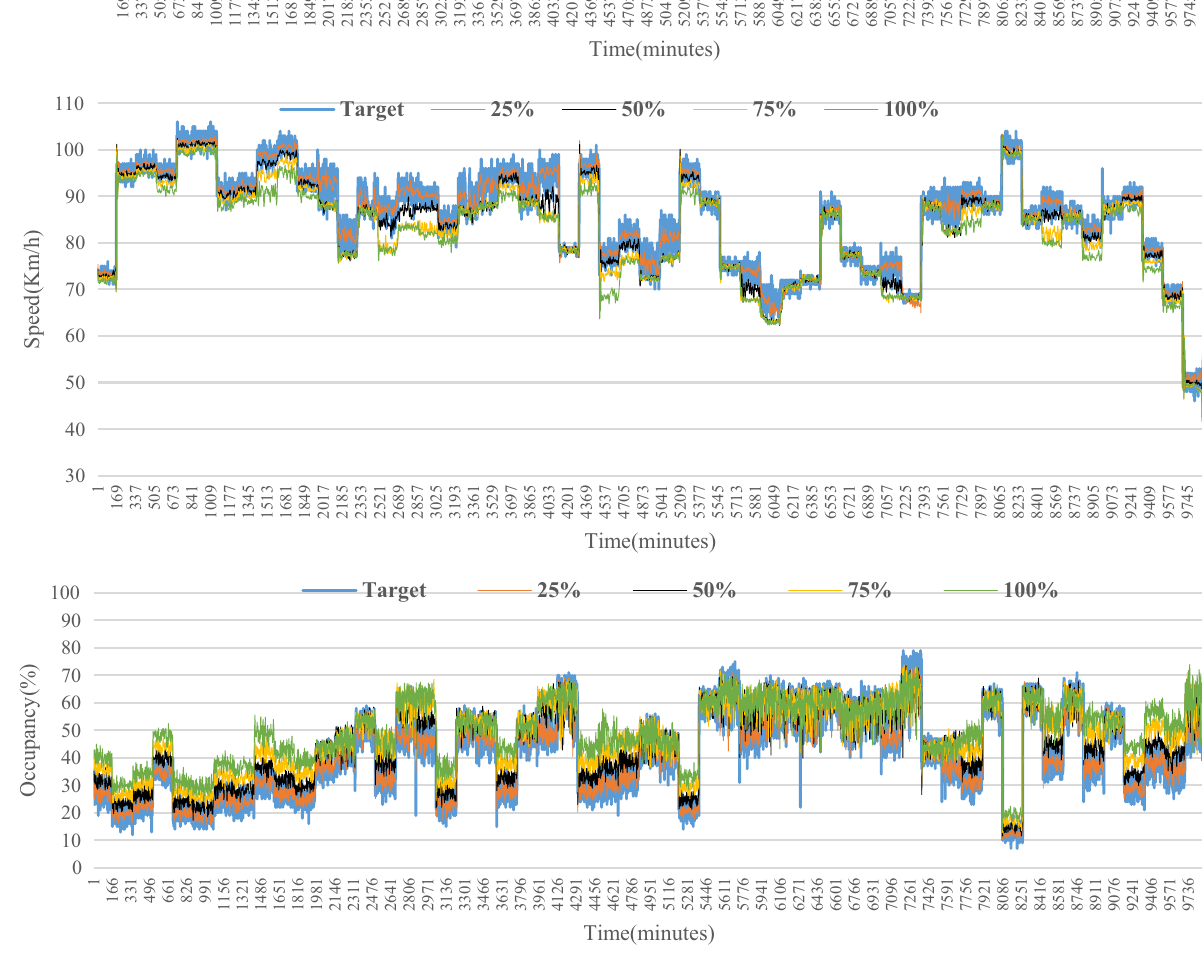
Figure 13. Count, speed and occupancy prediction results for all scenarios on 15 min prediction